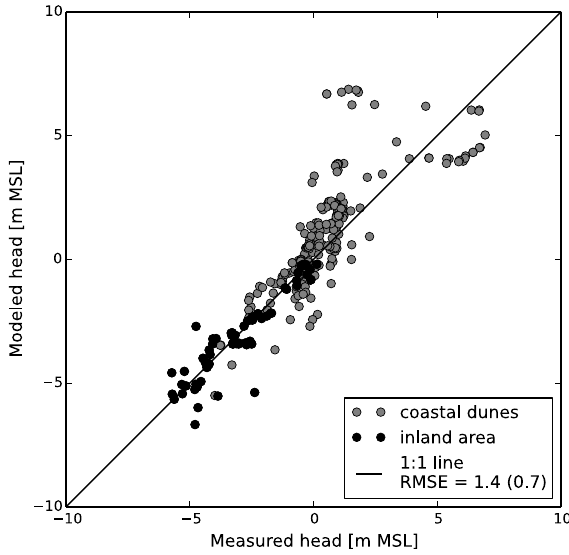
Figure 4. Comparison of measured versus modeled heads. Loca- tions (Fig. 1) were selected within a trapezoidal buffer (0.5km at the surface to 5km at 300m depth) around and projected orthog- onally onto the modeled transect. Measurement values are the av- erage of time series of head measurements from AD1990 onwards containing at least 25